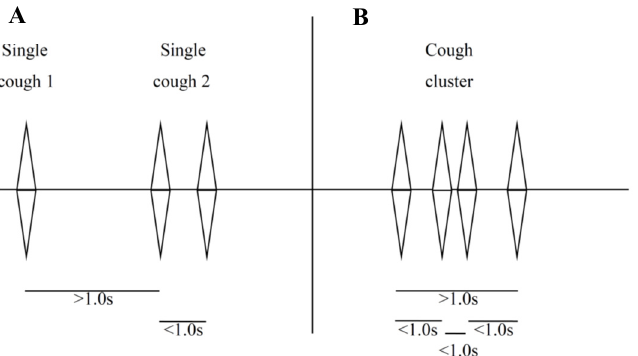
Figure A1. ( A )—Example for single coughs. One cough or multiple coughs with a total duration <